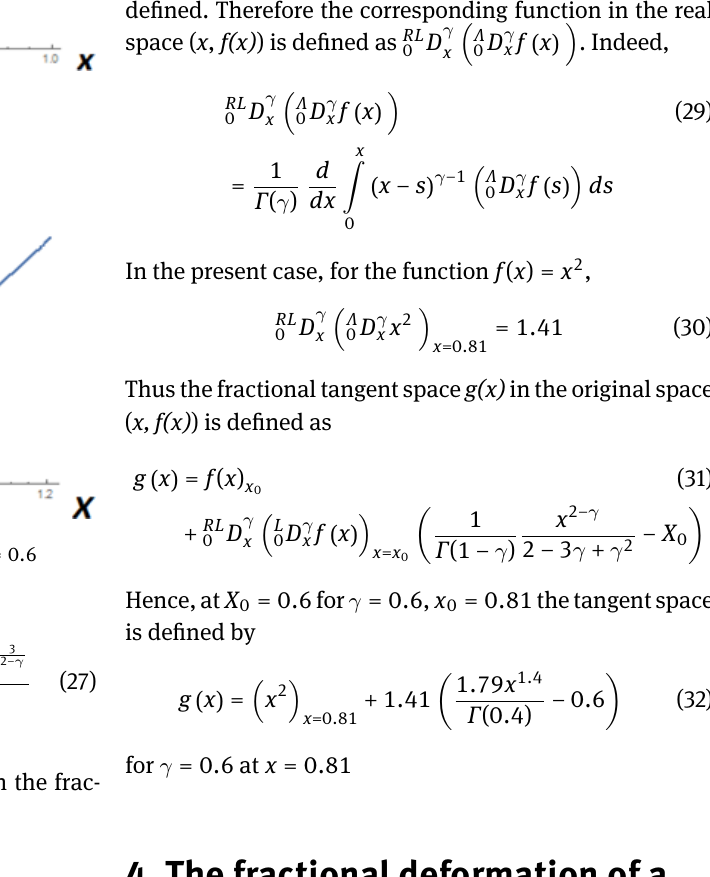
in dX D 𝛾 x f ( x ) is 0